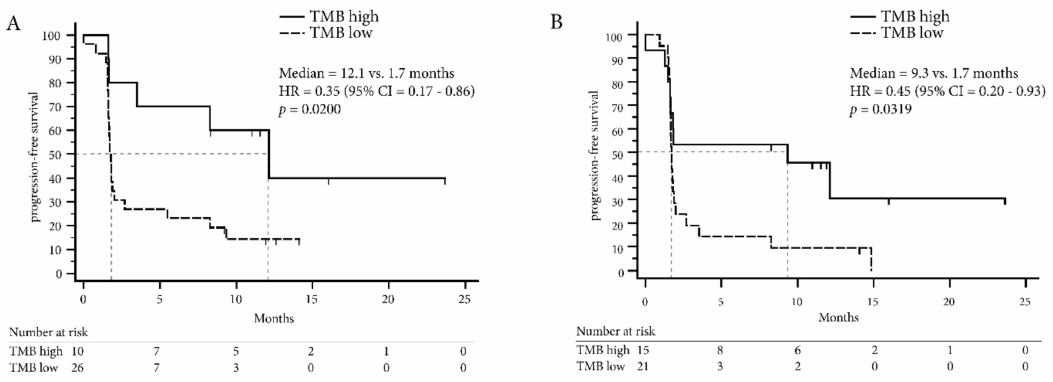
Figure 3. Progression-free survival according to TMB in non-small cell lung cancer patients. ( A ) Progression-free survival (PFS) is computed for the NSCLC dataset using the Oncomine TML panel (OTML) and ( B ) the FoundationOne test